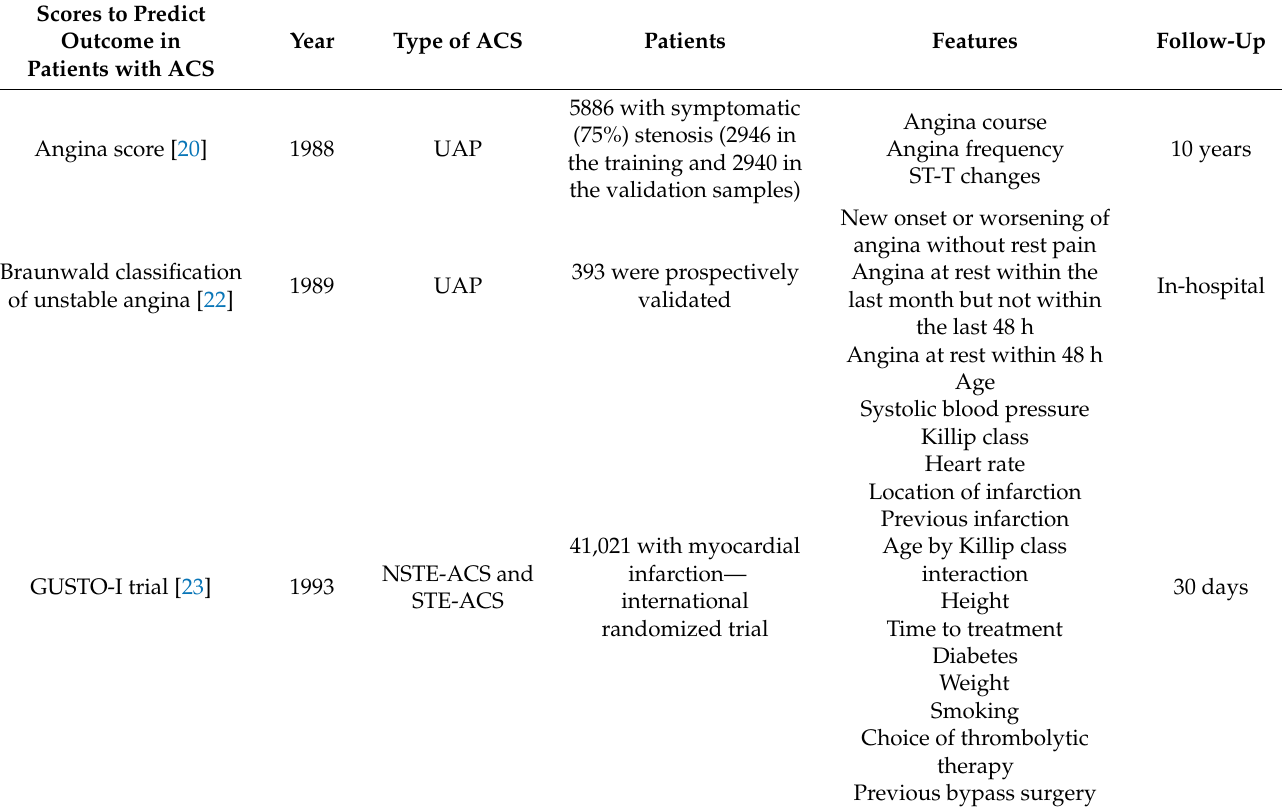
Table 1. Summary of risk models predicting the outcome of patients with acute coronary syndrome (ACS). Scores to